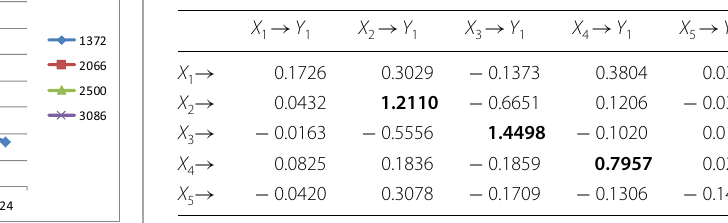
Table 3 Direct and indirect path coefficients of various variables affecting basic wood density ( Y 1